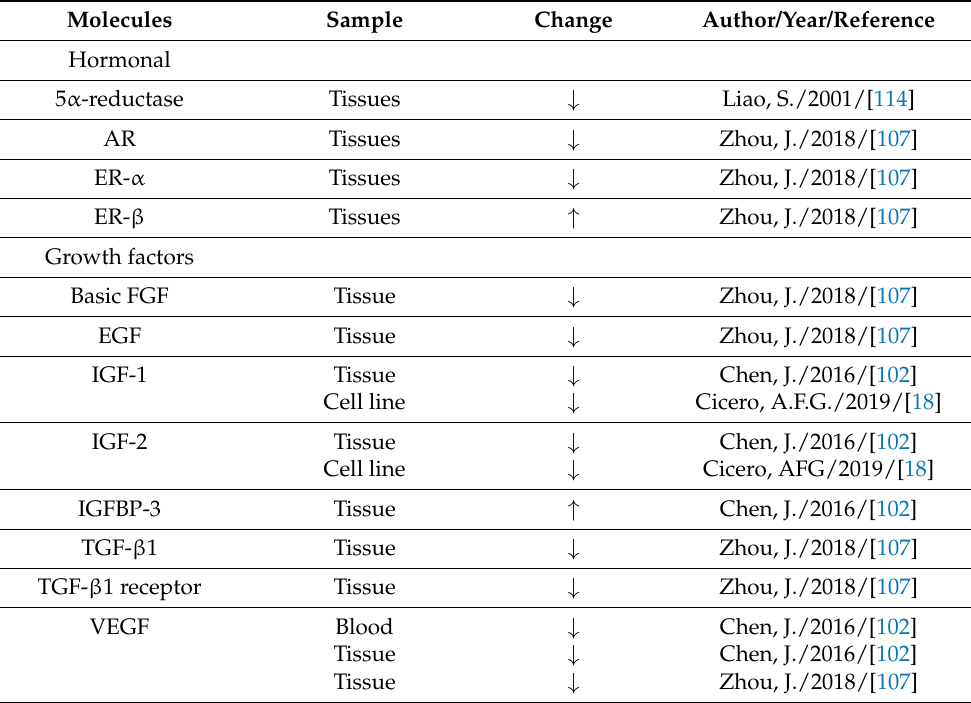
Table 2. Changes of hormone-related molecules and growth factors by green tea polyphenol.